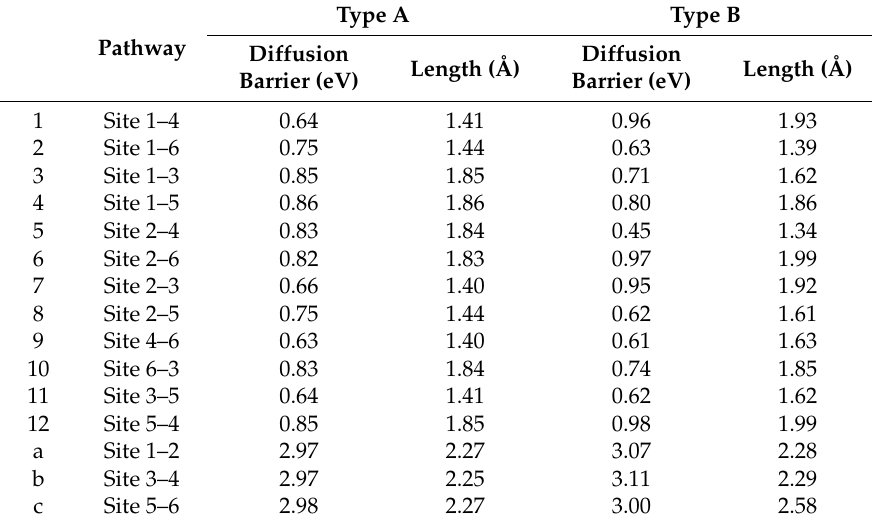
Table 3. Energy barrier for different tritium diffusion paths in type A and type B vacancies. Type Pathway